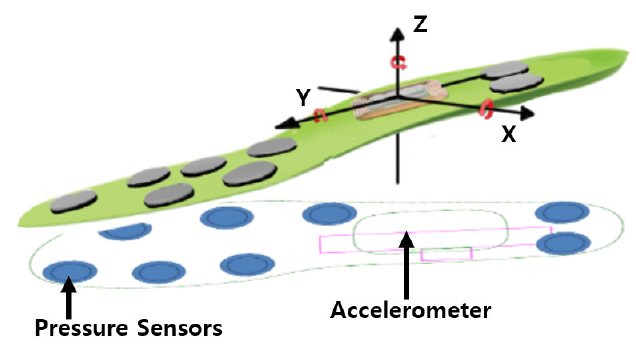
Figure 1. Sensor structure of the smart insole,